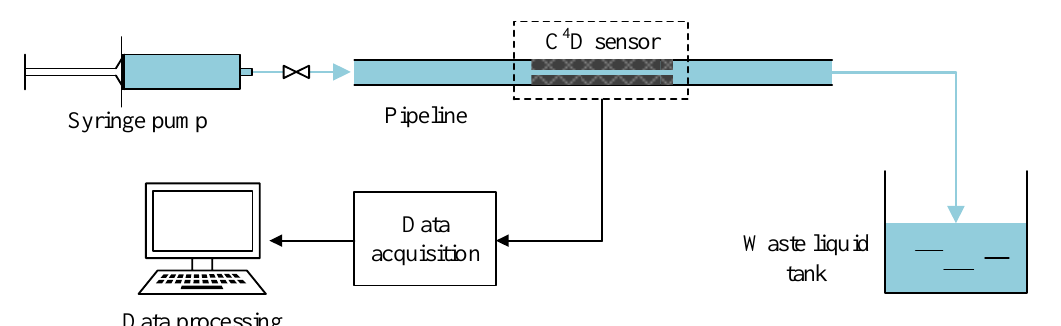
Figure 11. The layout of the experimental setup.